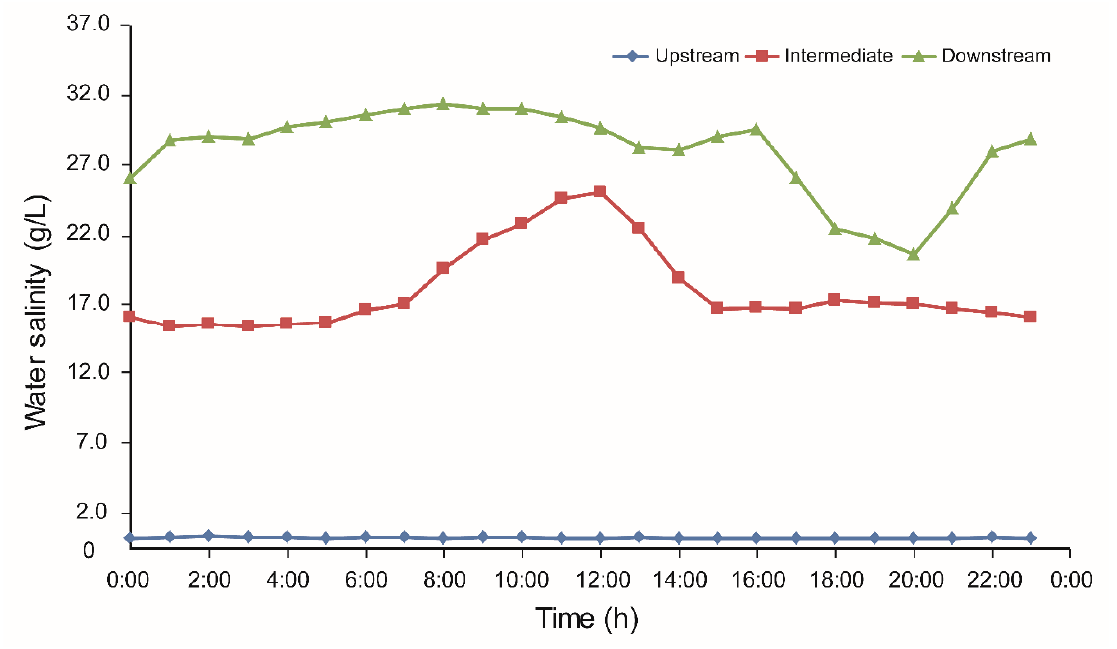
Figure 2. Typical diurnal change of the surface water salinity at the upstream site, intermediate site and downstream site of the Wenchang River, Hainan, China.